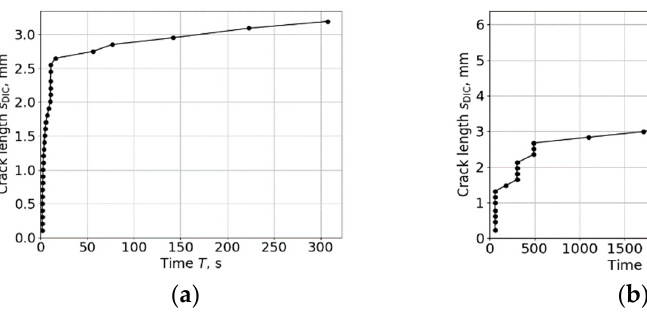
Figure 7. Field of crack maximum normal strain ( upper row ) and temporal dependencies of the calculated crack length ( lower row ) for rail ( a ), wheelset ( b ), and traction clamp ( c ) samples.